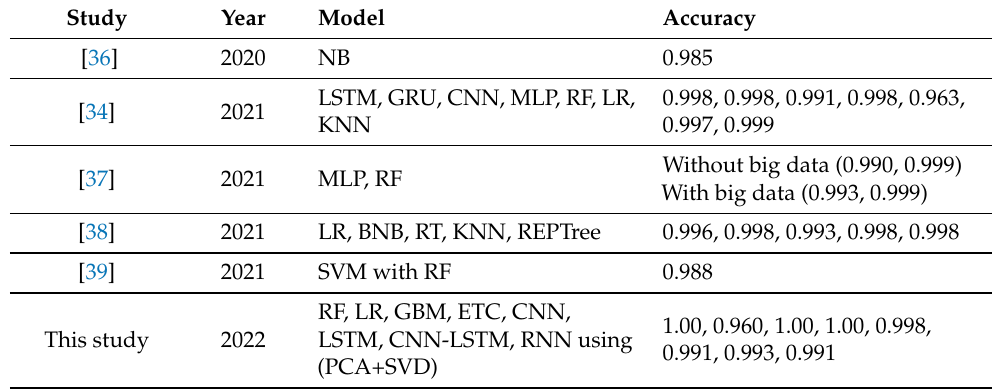
Table 15. Comparison with other